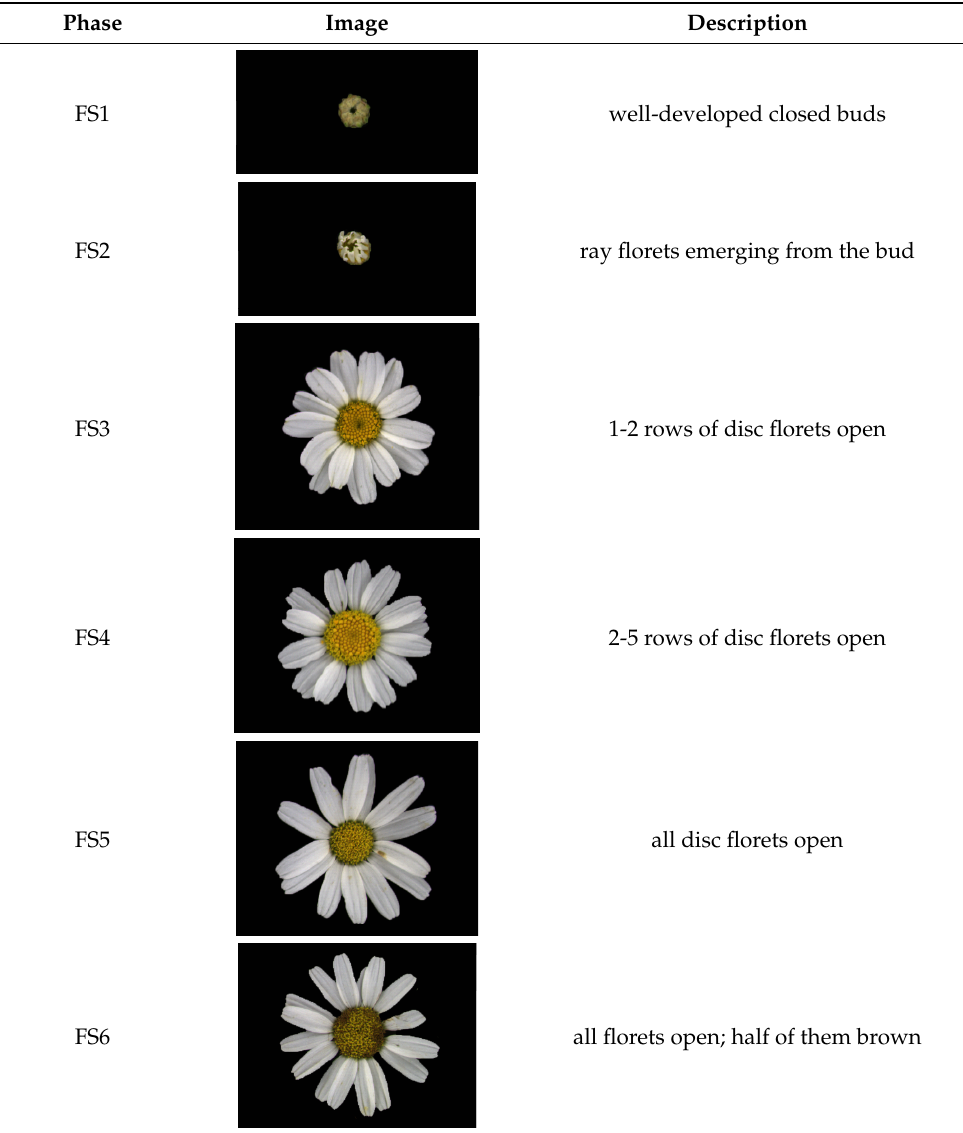
Table 2. Flower developmental stages of Dalmatian pyrethrum.